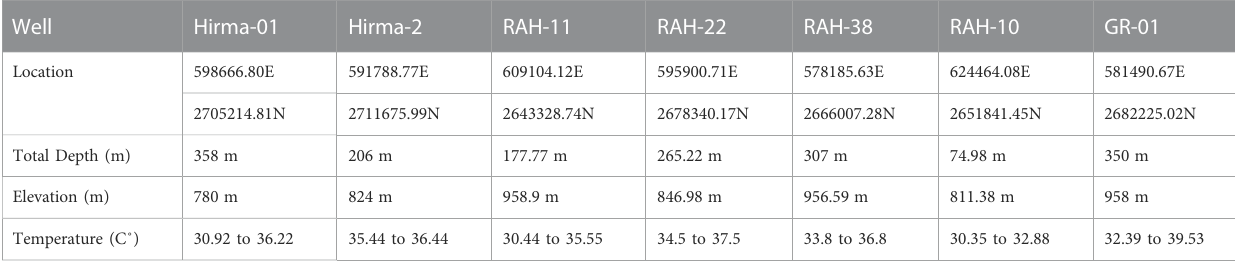
TABLE 1 Details of the selected or the drilled wells within the study area. Well